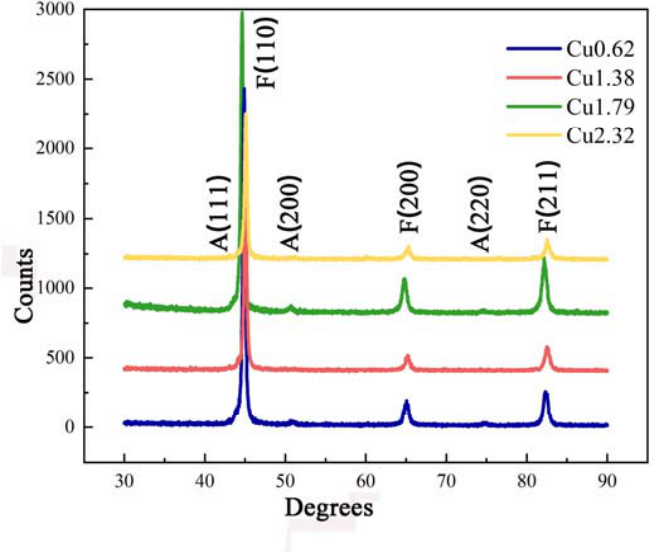
Figure 3. XRD patterns of deposited metals with different Cu addition. A means γ ‐ Fe, F means α‐ Fe. From the crystallographic morphology observed by EBSD, the microstructure of